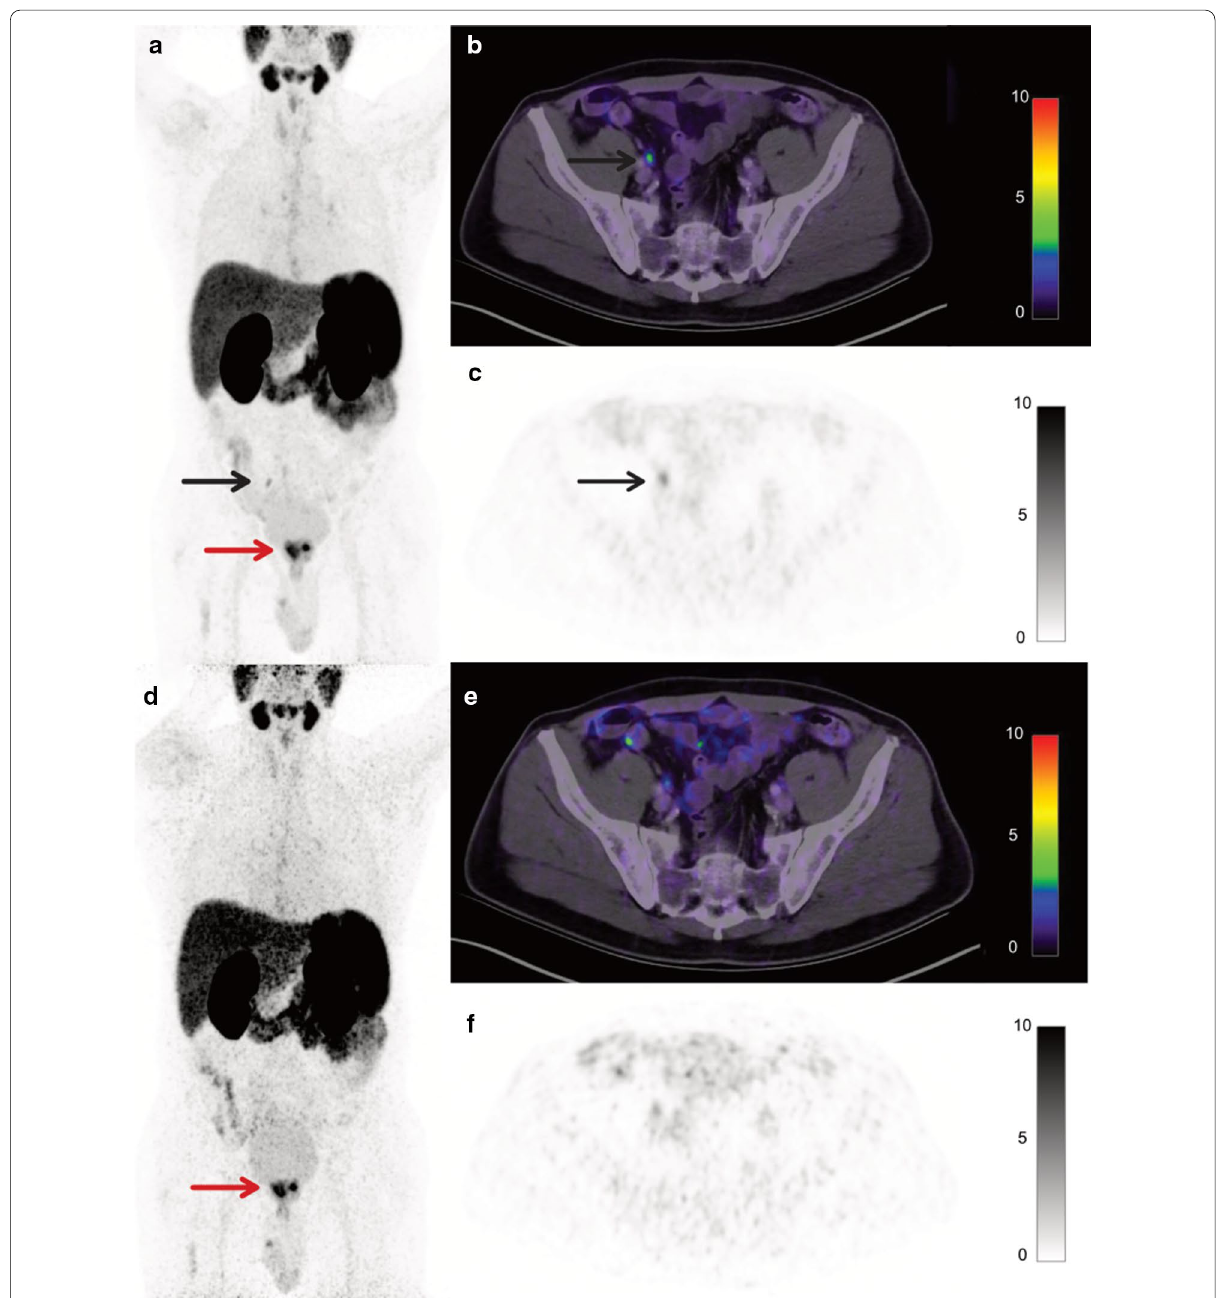
Fig. 2 A 61-year-old patient (Pat ID #13) with biopsy-proven prostate cancer undergoing [ 68 Ga]Ga-PSMA-11 PET/CT for initial tumor staging before treatment. Gleason Score was 9, PSA was 18.3 ng/ml at the time of imaging. a – c show images acquired with the reference acquisition protocol; d – f show images acquired with the reduced acquisition protocol all reconstructed with OSEM-PSF TOF(4i). Maximum intensity projection ( a , d ) and + axial [ 68 Ga]Ga-PSMA-11 PET/CT slices ( b , c , e , f ) show local tumor (red arrows). One right pelvic lymph node metastasis (black arrow) could not be unequivocally detected with a three and a half-fold scan time reduction ( c , f ). Until now the patient has not undergone surgery, a follow-up scan performed more than 6 months later confirmed the prostatic and lymph node